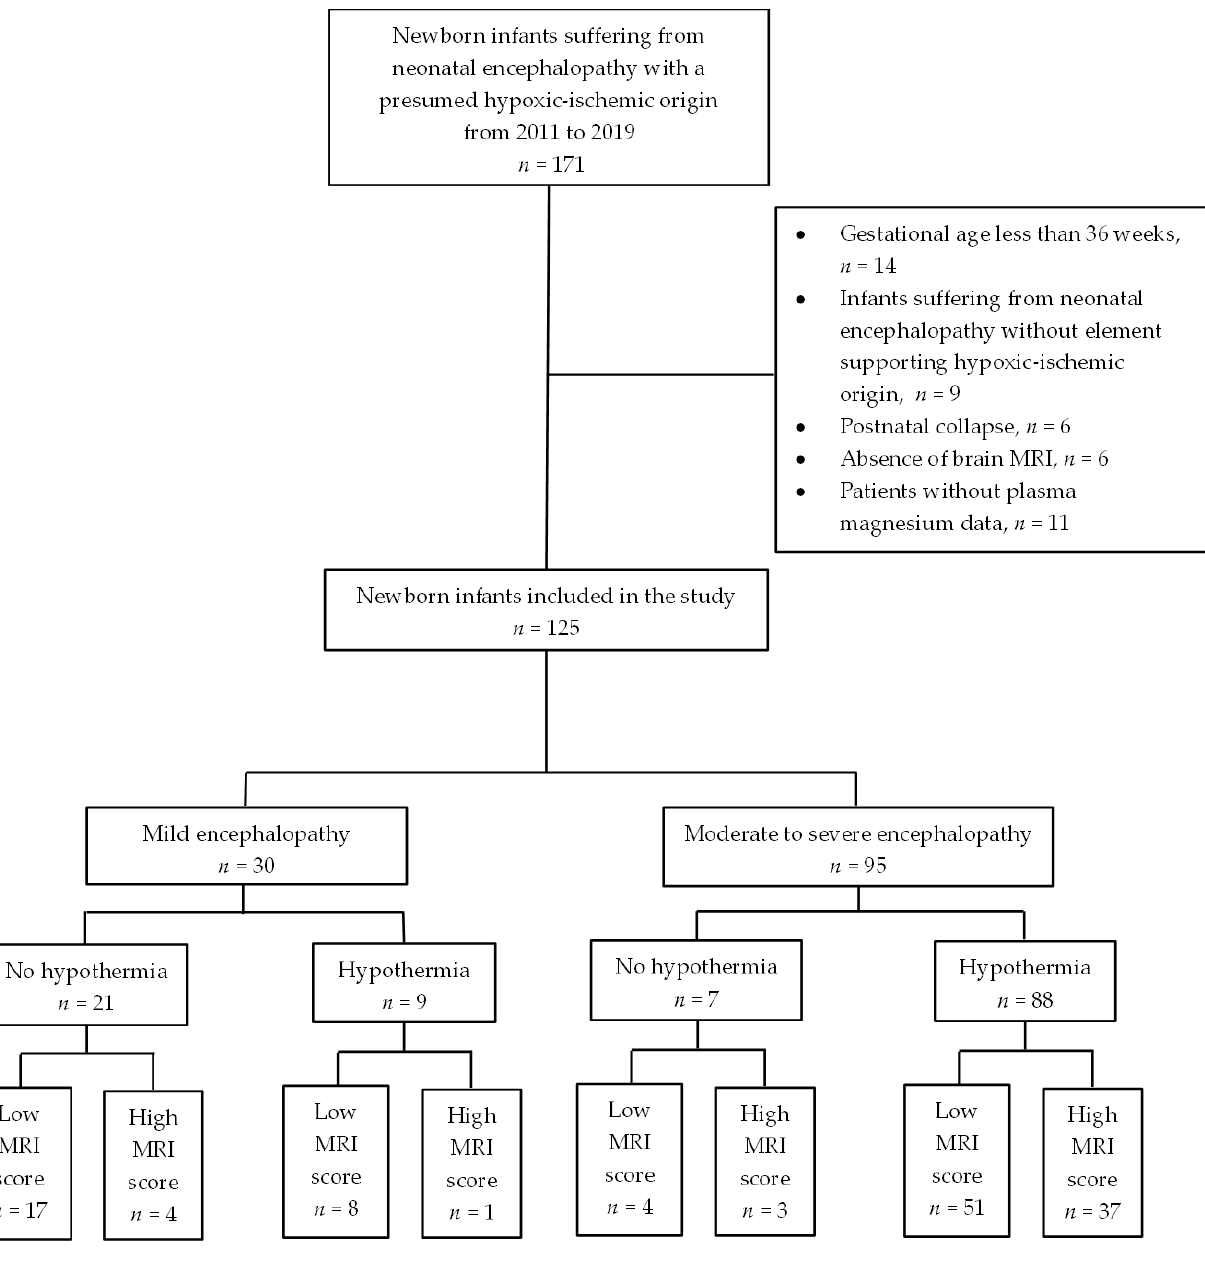
Figure 1. Flow-chart of the study. Infants with a high MRI score experienced a significant drop in plasma magnesium for the first 24 h of life that was not observed in infants with a low MRI score (low MRI score ( n = 43): − 0.01 mmol/L (0.1) vs. high MRI score ( n = 14): − 0.2 mmol/L (0.15), p < 0.0001, Figure